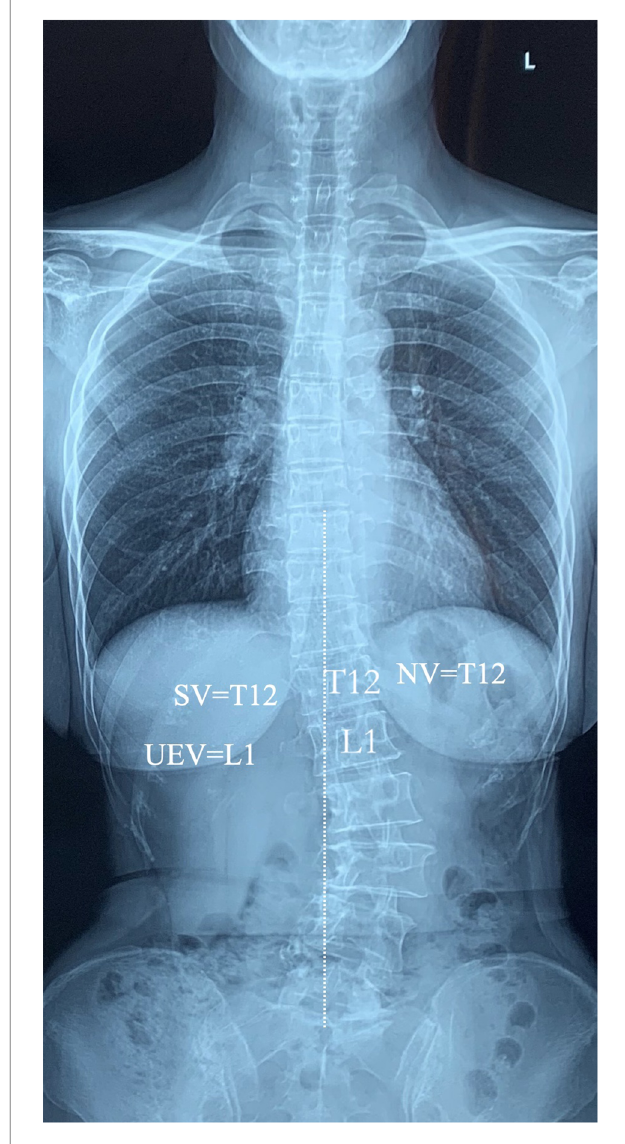
FIGURE 1 Schematic demonstrating the upper end vertebra, neutral vertebra (not rotated; pedicles and body symmetric, spinous process midline), and stable vertebra (CSVL bisects